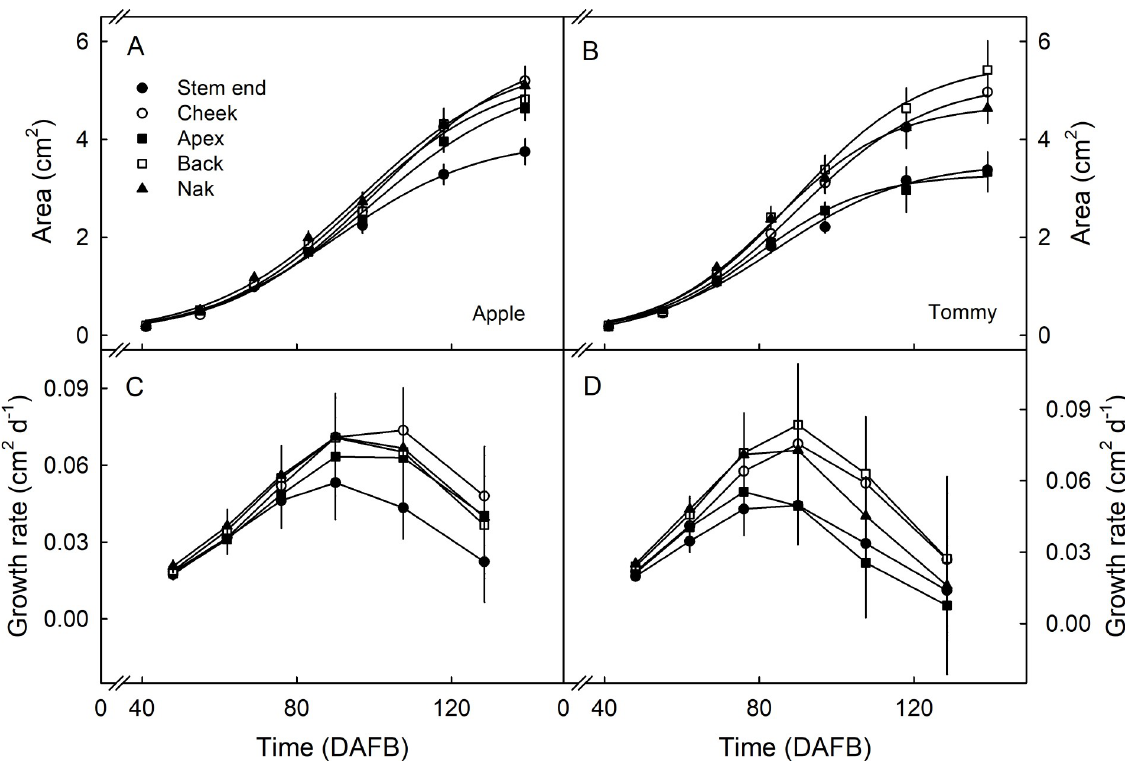
Fig 3. Time course of change in area (A,B) and growth rate (C,D) of selected regions of the fruit surface of ‘Apple’ (A,C) and ‘Tommy Atkins’ (B,D) mango. A square pattern of dots of white silicon rubber was printed in the stem end, the cheek, the apex, the back or the nak region of the fruit surface at 41 days after full bloom (DAFB) and the expansion of the dot pattern monitored. For location of the regions on the fruit surface see Fig 1. Data represent means ± SE. The number of replicates was 16–30.